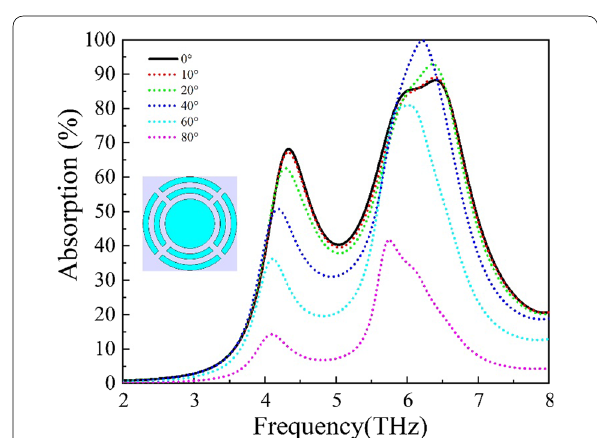
Fig. 6 THz wave absorption of periodic structures of a combination of two split-rings and an Al disk with different incident angles. The two split-rings have a ring width of 2 μm, an opening width of 2 μm and an outer radius of 17 μm and 13 μm, respectively. The Al disk has a radius of 9 μm and a thickness of 10